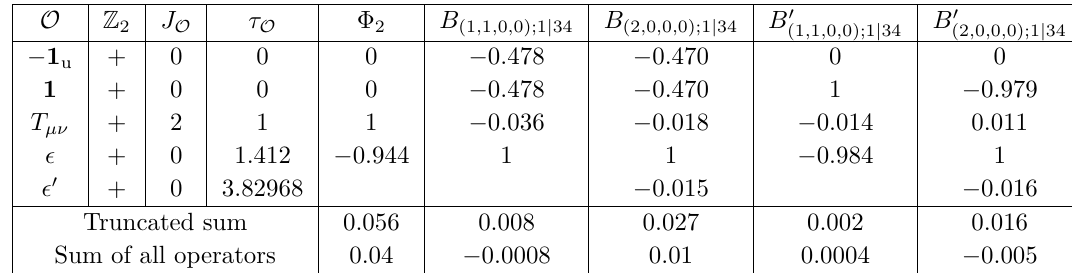
Table 5 . Contribution of each operator to the h σσσσ i sum rule with v = 1 ; these results include the contribution of the OPE coefficient square f 2 the largest contribution to the sum rule in order to be comparable to the Φ operators contribute to order O (10 − 3 ) and less. Finally, the sum of all operators must add up to 0 in accordance with eq.